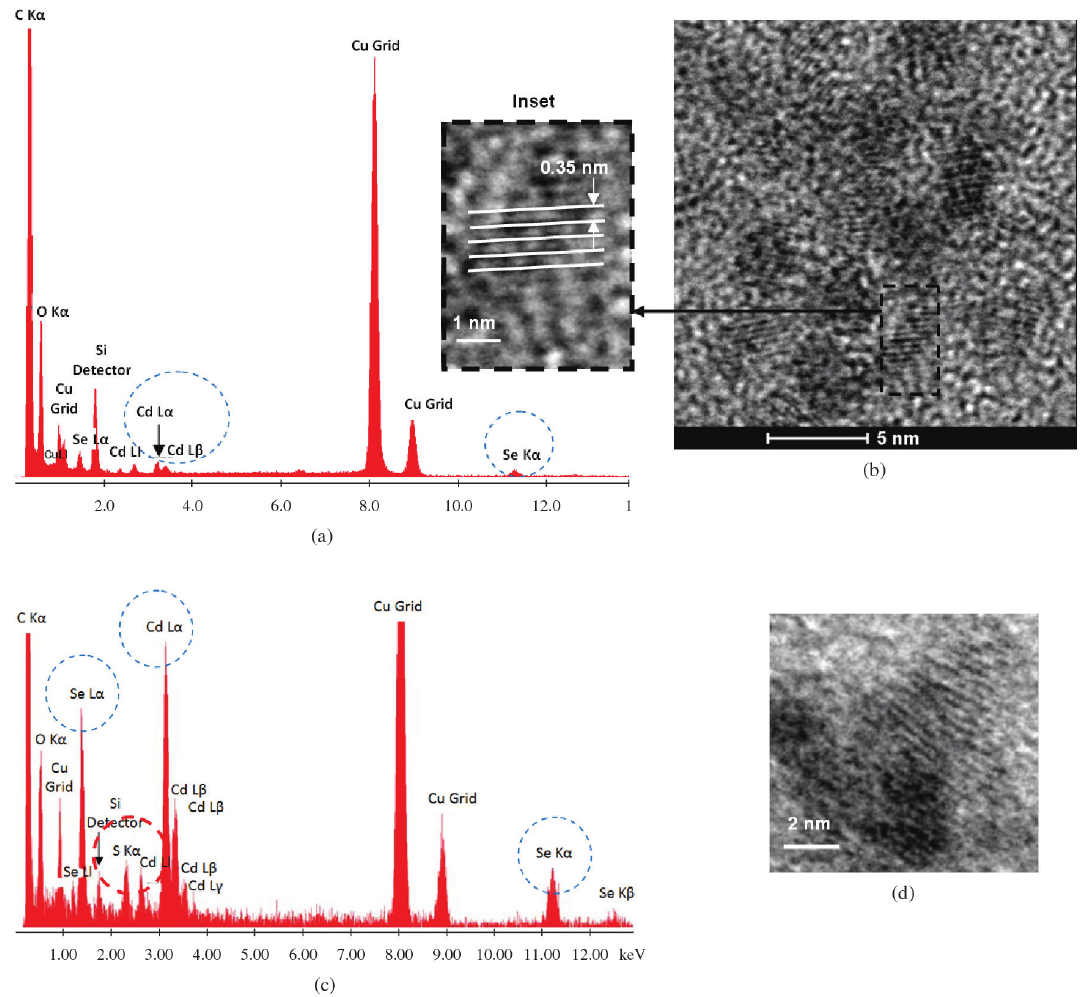
Figure 6. EDS spectra of the CdSe core (a) and CdSe/CdS core-shell-1 st monolayer (c). TEM image of the CdSe core (b) and CdSe/CdS core-shell-1 st monolayer (d). Inset: lattice arrangements by electron diffraction with detailed nanocrystal plane